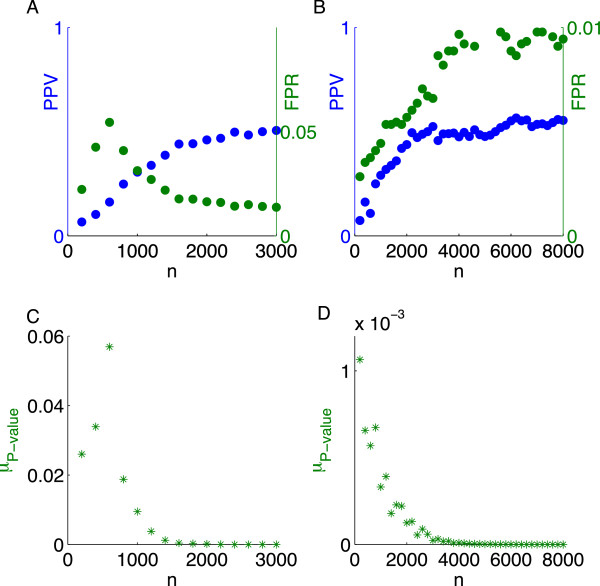
Measures of selection as a function of sample size for chromosome 22 (s = 125 and p = 8, 915). The PPV (blue) and FPR (green) for h2 = 1 (A) and h2 = 0.5 (B). μP − value for h2 = 1 (C) and h2 = 0.5 (D).